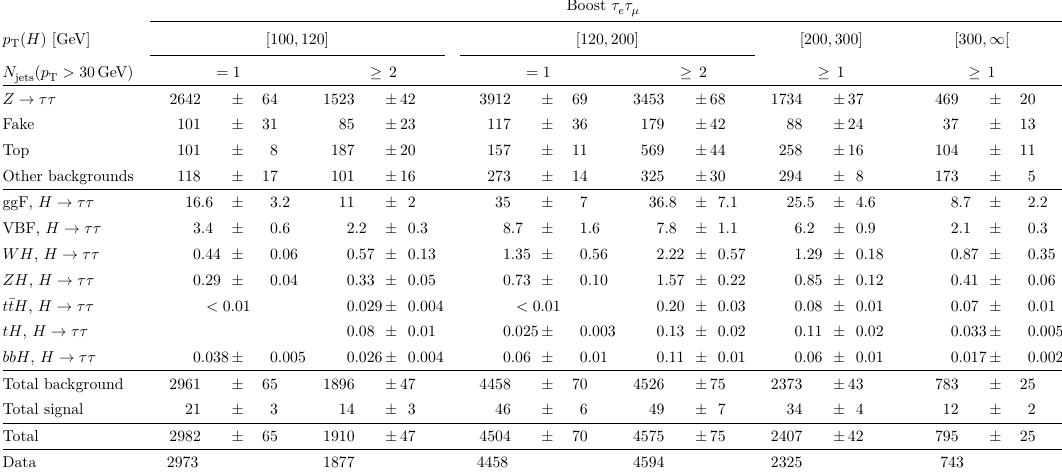
Table 13. Observed event yields and predictions as computed by the fit in the boost signal regions of the τ τ channel. Uncertainties include statistical and systematic components. The prediction e µ for each sample is determined from the likelihood fit performed to measure the pp → H → ττ